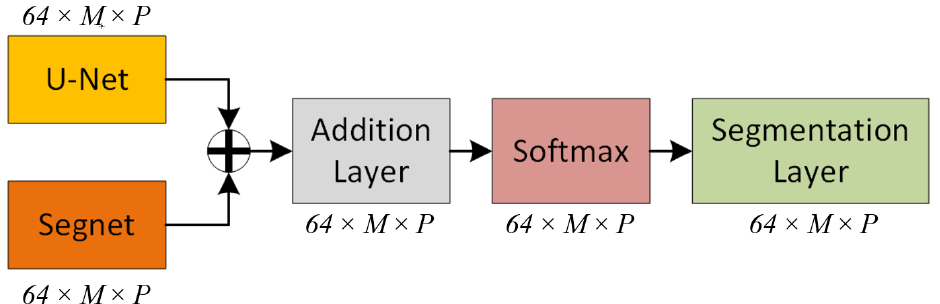
Figure 4. Addition of weights of two